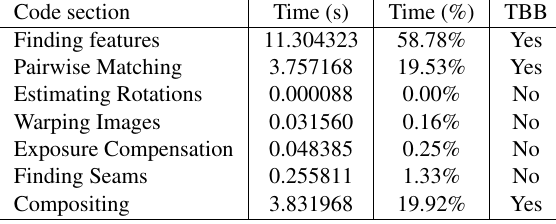
Table 1: Coverage of the different stitching algorithm sections